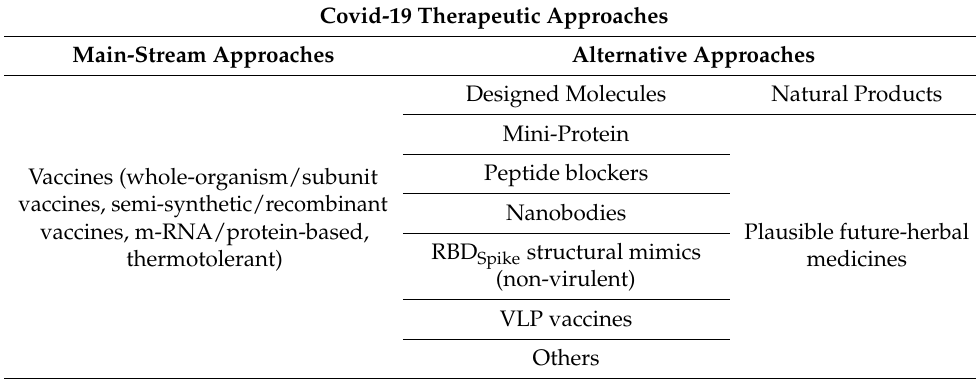
Table 1. Look-up table portraying the range of therapeutic approaches to combat the ongoing Coronavirus